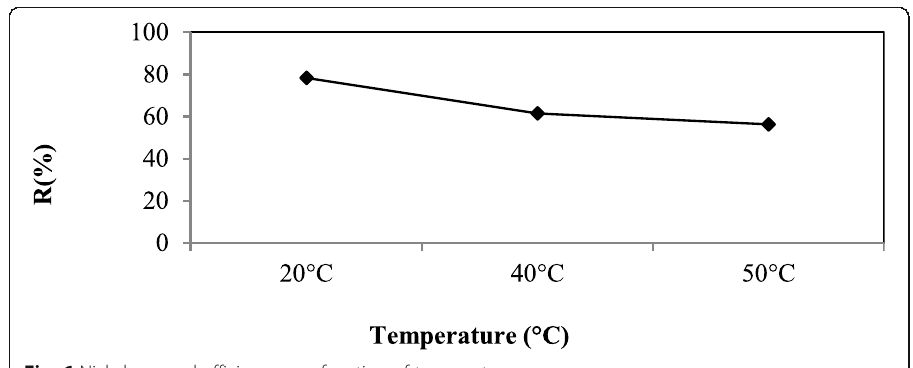
Fig. 6 Nickel removal efficiency as a function of